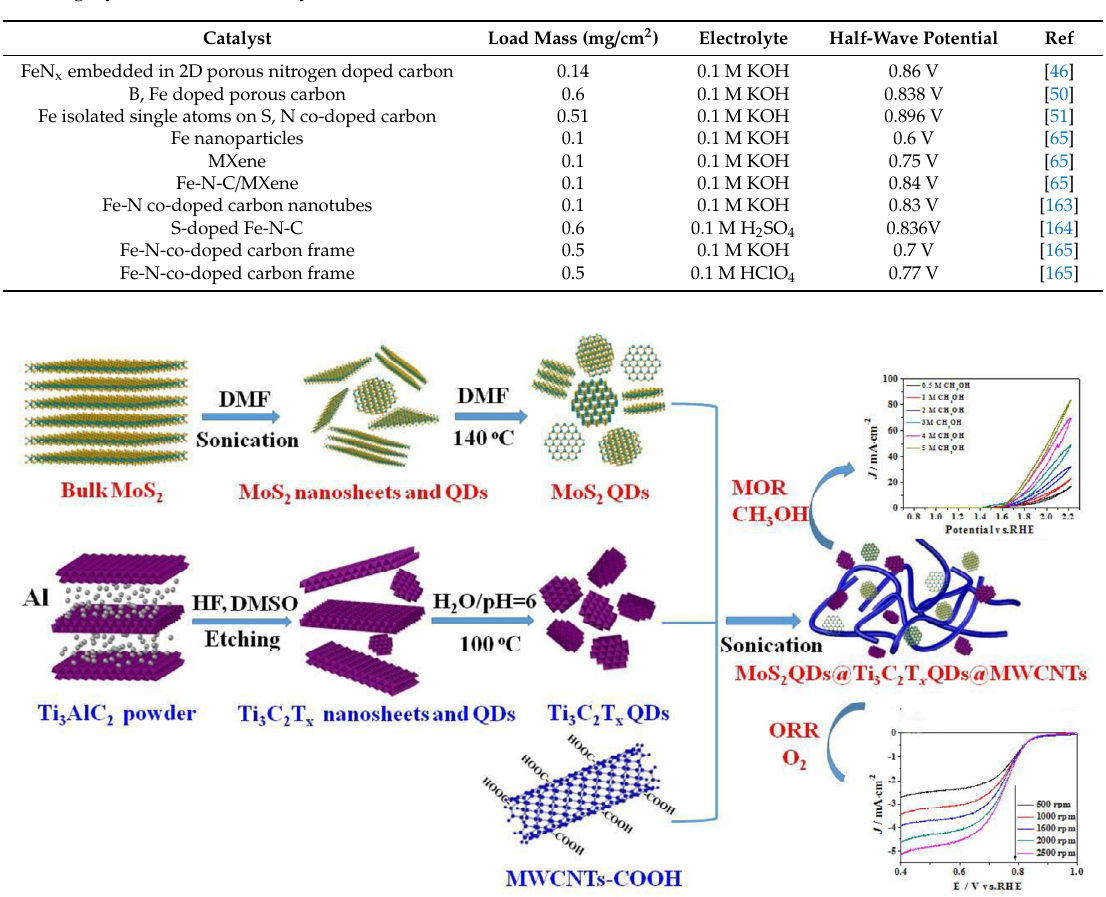
Table 7. Summary of the ORR activity for the synthesized MXene composites with recently reported highly active electrocatalysts.